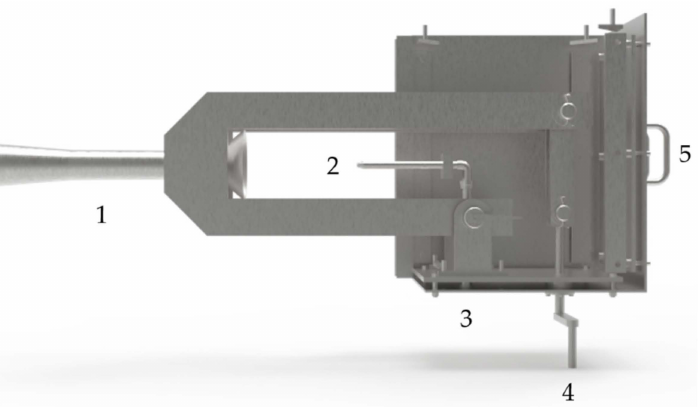
Figure 1. FJBS jet blower 1-jet blower, 2-motive medium nozzle, 3-location of nozzle supply, 4-tilting mechanism, 5-revision